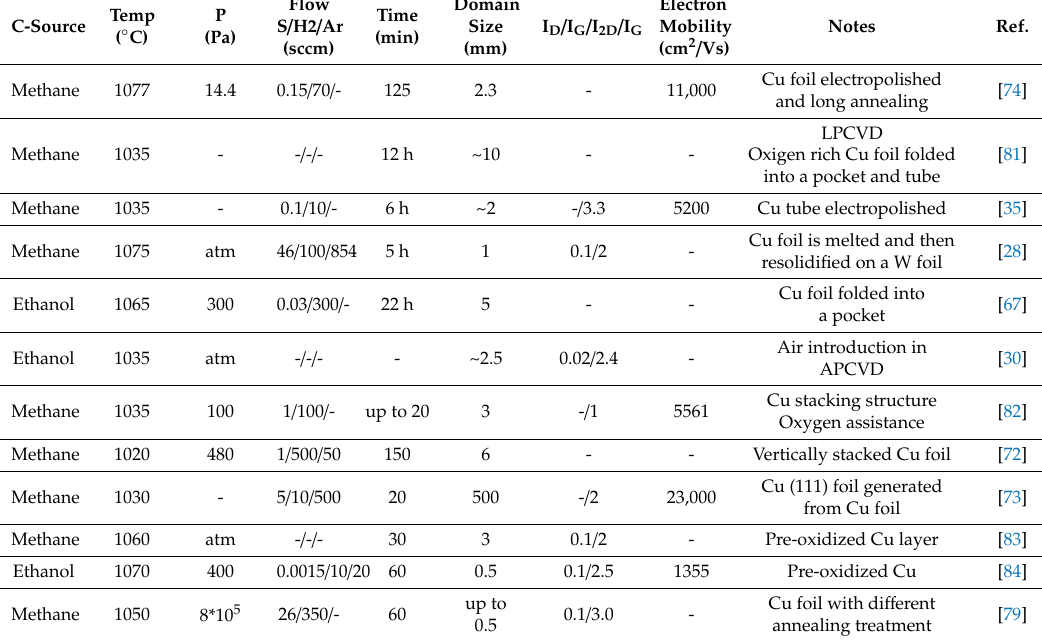
Table 2. Summary of selected methane and ethanol CVD conditions reported in literature to grow high quality single-crystal graphene grains on Cu